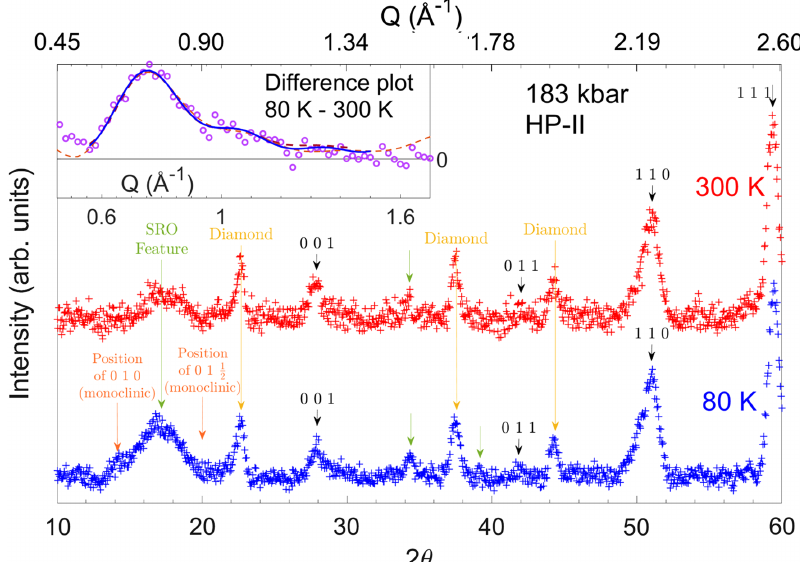
FIG. 6. Powder neutron diffraction patterns of FePS 3 at 183 kbar at 80 and 300 K taken on D20, ILL. Peaks originating from the sintered diamond anvils are marked in orange. Nuclear Bragg peaks are marked as indexed in the trigonal HP-II phase. Broad temperature-dependent features indicative of short-range magnetic order are labeled in green. In dark orange are marked the positions of Þ in the monoclinic symmetry of the HP-I phase for ease the magnetic order peaks which are described by k ¼ ð 0 ; 1 ; 0 Þ and k ¼ ð 0 ; 1 ; 1 2 of comparison to earlier figures. These same magnetic structures, of course, have different indexing in the trigonal symmetry, but the d spacings remain as shown. The inset shows the result of subtracting the 300 K data from the 80 K plotted against Q — the SRO feature grows as temperature is decreased. The blue solid line through these data shows the RMC fit to this feature with spins constrained to be collinear (the fit used for the analysis) described in the text. Red and orange dashed lines show fits with unconstrained moment orientations, over two different Q ranges, to show the robustness of the